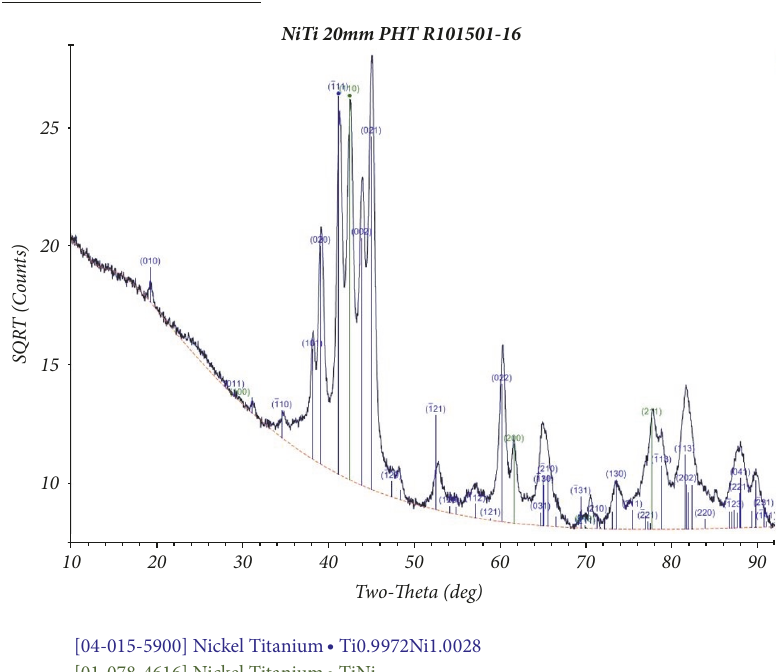
Figure 6: The XRD spectrum is consistent with a mixture of Martensite and Austenite, and lacks signature peaks from other intermetallic compositions.